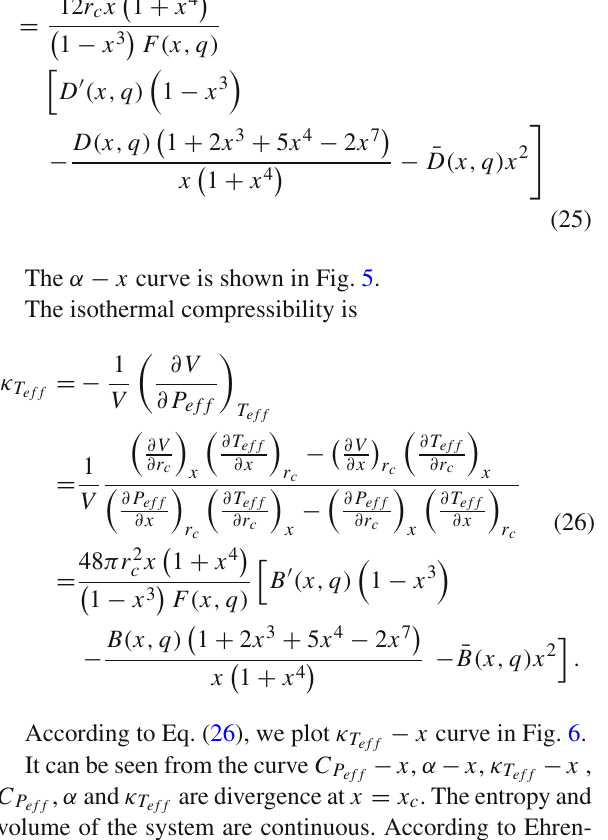
= 2, c = 3 . 18, q = 1 . 7, r 1 2